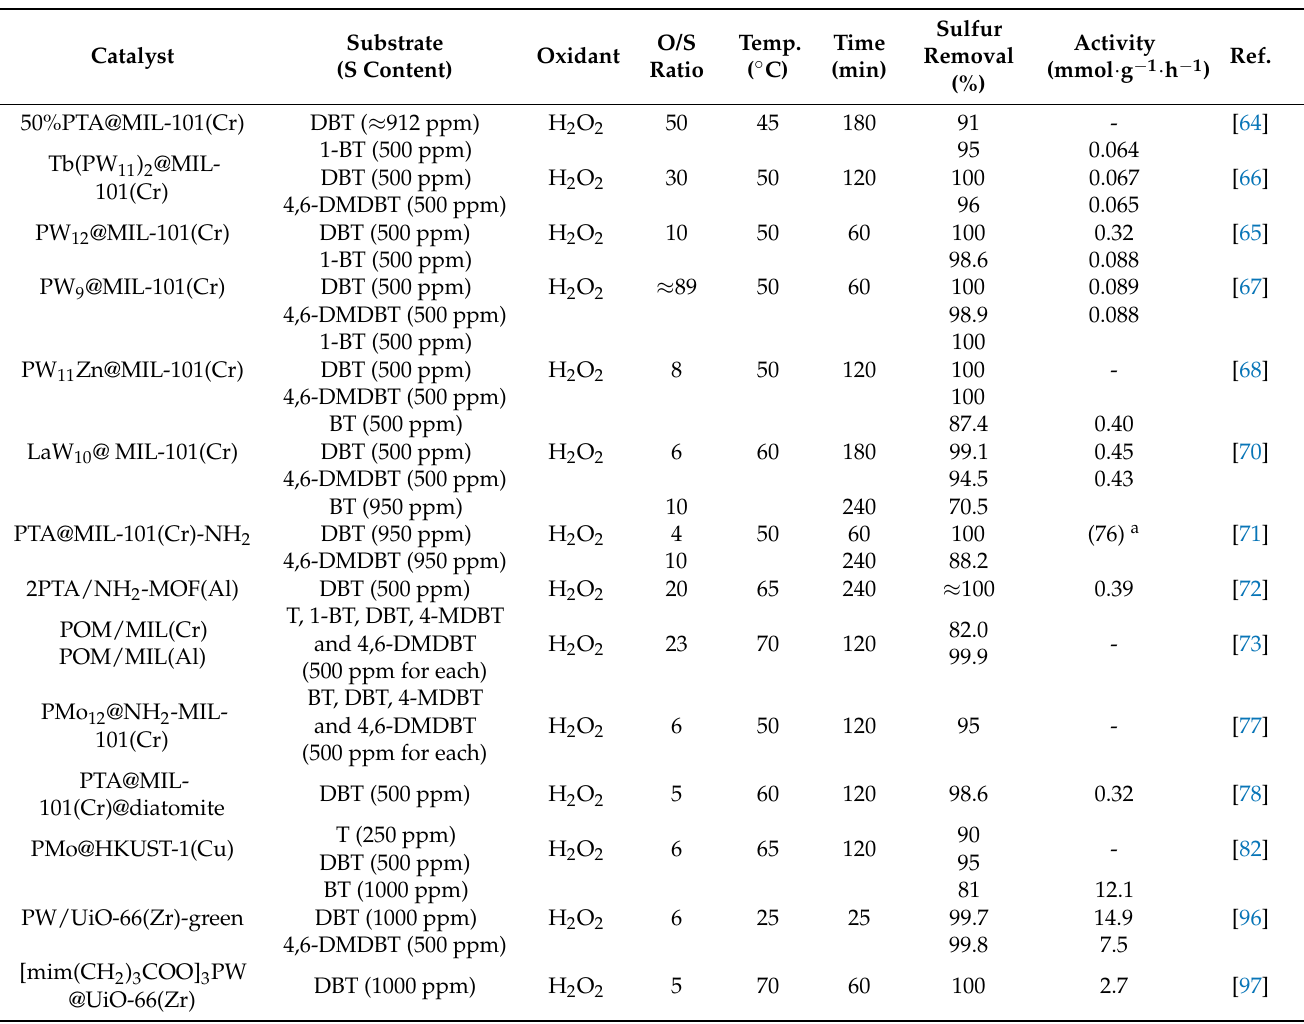
Figure 6. Diagram of the synthetic processes of PW/UiO-66(Zr)-solvent and PW/UiO-66(Zr)-green (reproduced from Ref. [96], copyright 2020 Royal Society of Chemistry). Table 4. Comparison of catalytic performance over the composites of MOFs and POMs in the ODS reactions of model fuel